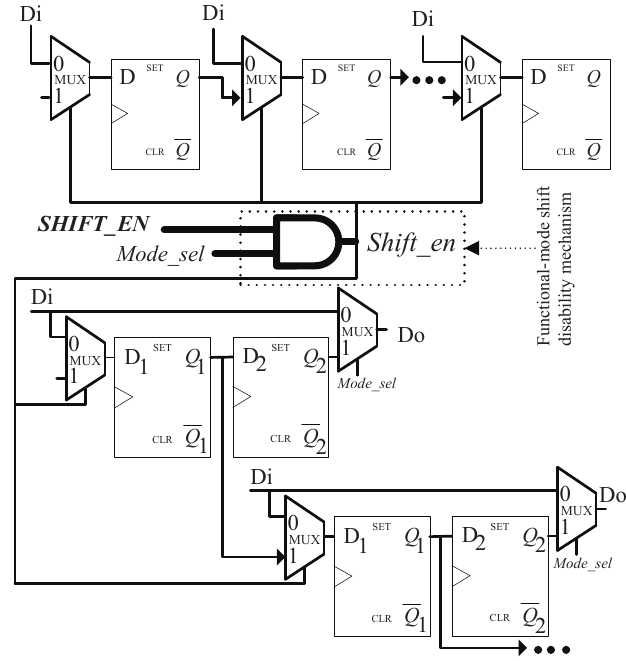
Figure 4. Functional-mode shift disability